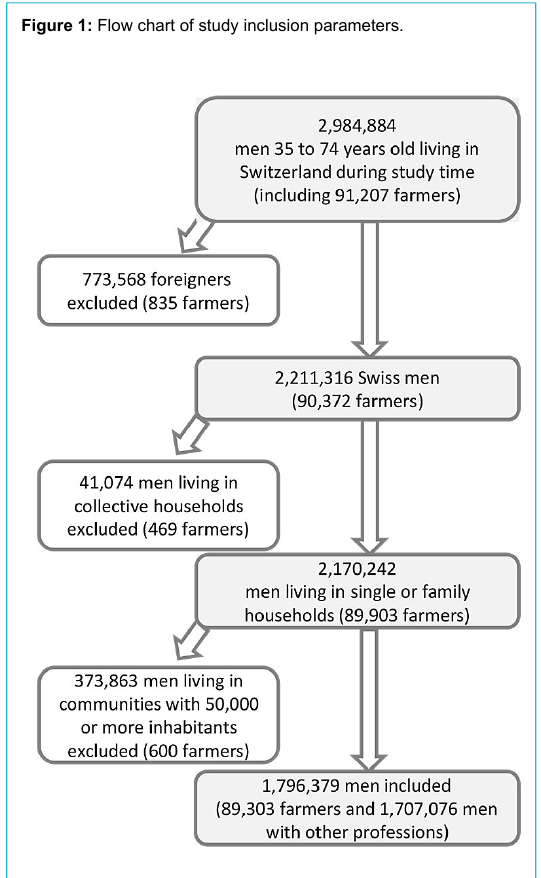
Figure 1: Flow chart of study inclusion